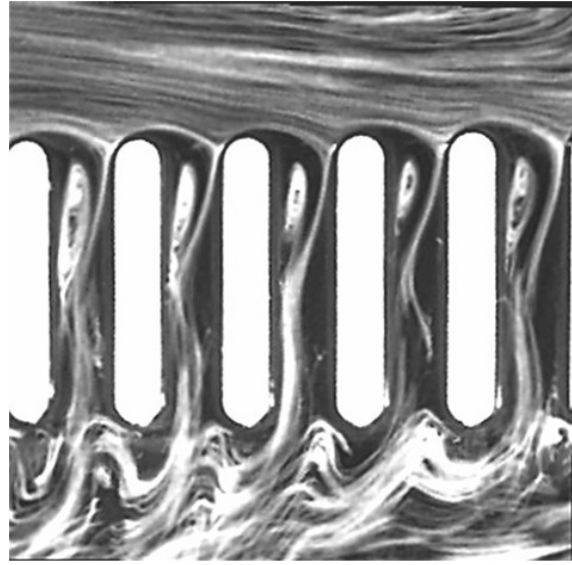
Fig. 18. Experimental refraction angle results. The angles  Z are strongly dependent on Reynolds number Re l evaluated from the cascade chord length l .